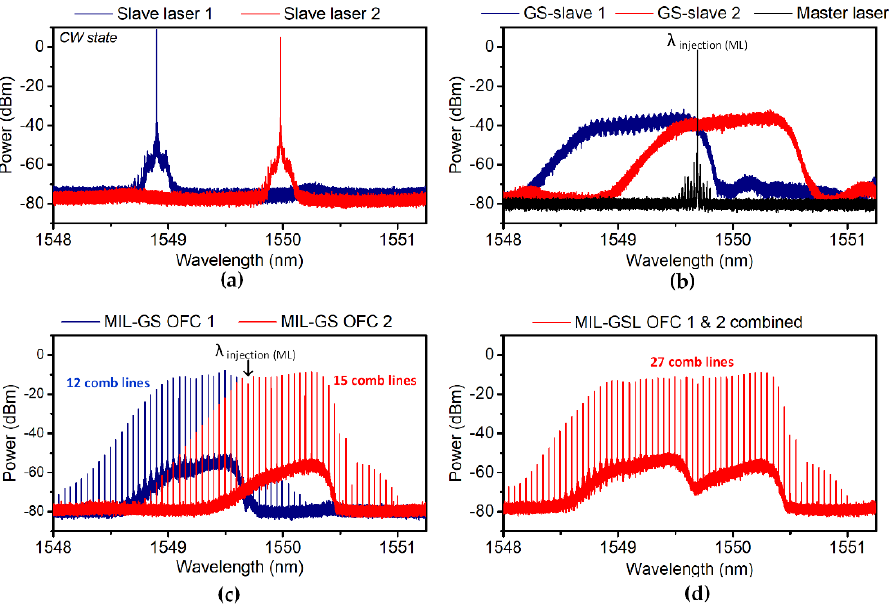
Figure 3. Optical spectra of ( a ) slave lasers in CW state; ( b ) Master and GS slave 1 and 2; ( c ) MIL- GS OFC 1 and 2; ( d ) Expanded OFC (combined MIL-GS OFC 1 and 2). OFC 1 and 2; ( d ) Expanded OFC (combined MIL-GS OFC 1 and